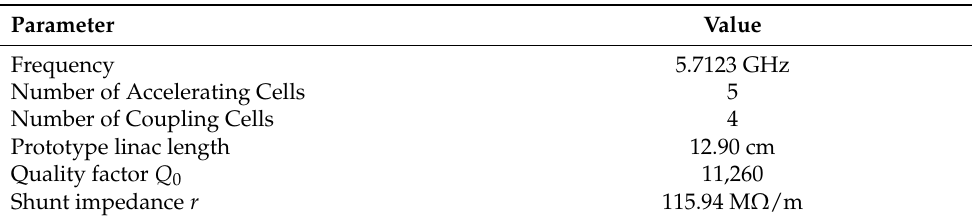
Table 2. Cavity RF